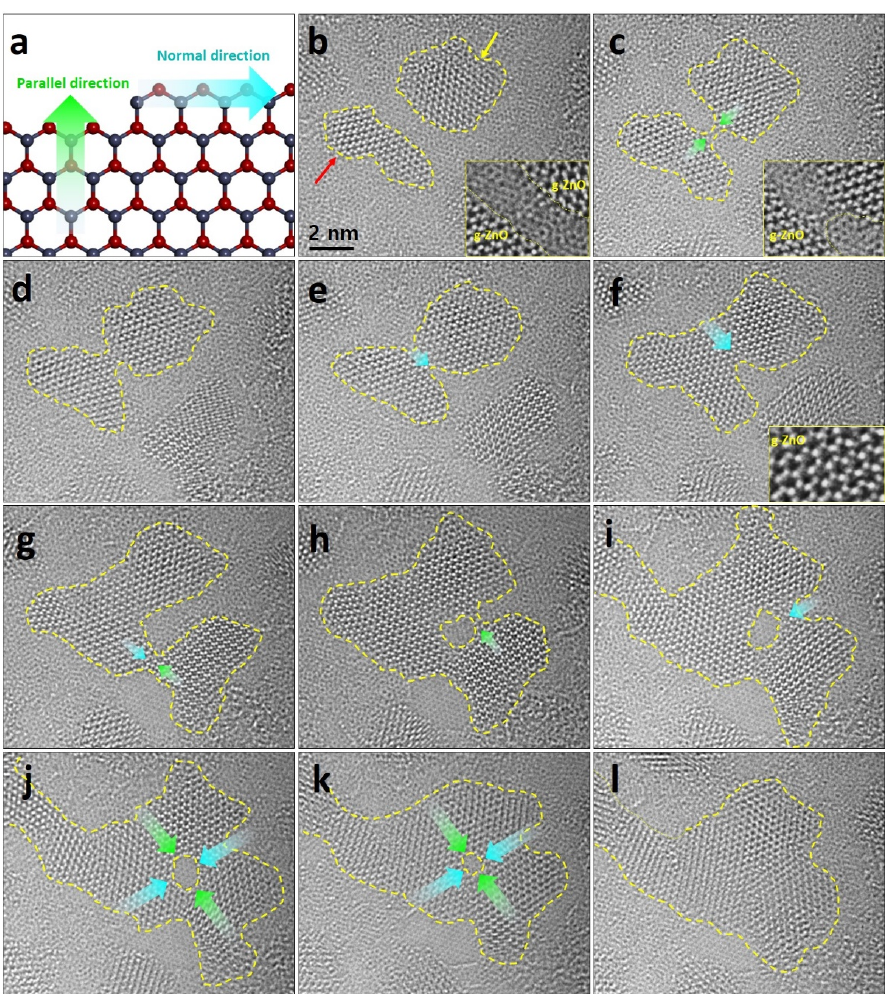
Figure 4. Merging of g-ZnO nano-flakes. ( a ) Atomic model showing normal and parallel to the growth direction. ( b ) Two graphene-like ZnO flakes before merging each other with magnified inset image showing edges of the flakes. Red and yellow arrows indicate that each flake is the same as flakes which are shown in Figure S2. ( c ) Initial state to merge the flakes along to the parallel directions of each flake. ( d – k ) Merging and expanding the flakes to the parallel and normal directions, indicated by green and cyan arrows. ( l ) Final g-ZnO flake after the process showing the behavior of merging and expanding.